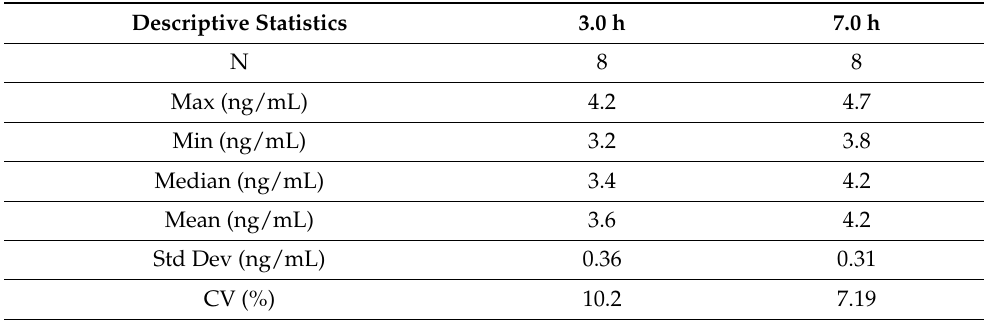
Table 5. Descriptive statistics for MTK concentrations in cerebrospinal fluid at 3.0 and 7.0 h post-dose after a single dose of 10 mg MTK oral mucoadhesive film in